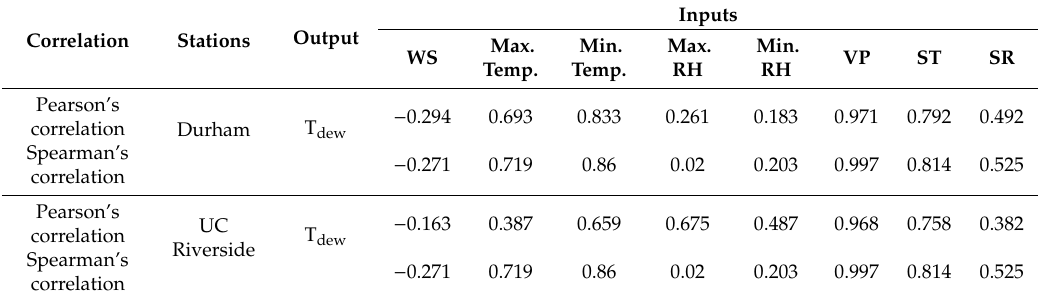
Table 2. The correlation matrix between dew point temperature and input